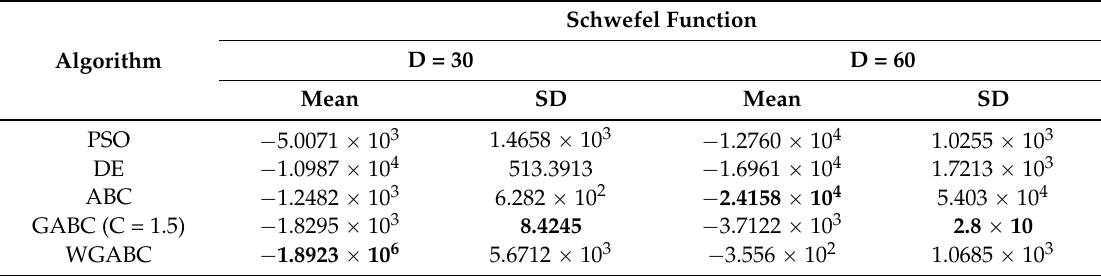
Table 3. The mean and standard deviation of the Schwefel function on the different algorithms.